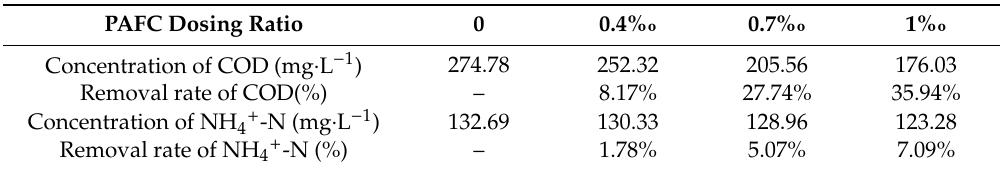
Table6. ComparisonoftheremovalrateofCOD Cr andNH 4 + -Nwiththeadditionratioofpolyaluminum ferric chloride